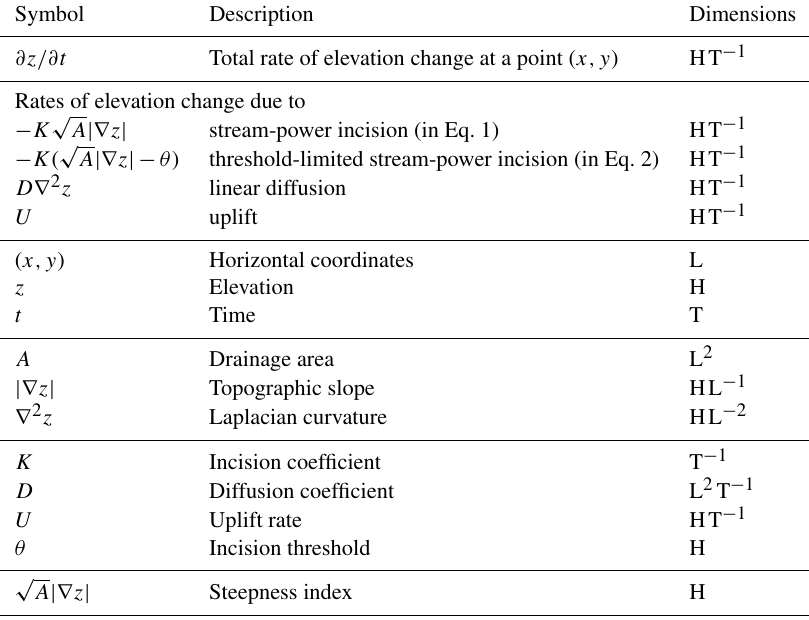
Table 1. Descriptions and dimensions of the terms, variables, and parameters in the governing equations (Eqs. 1 and 2). Dimensions are expressed in terms of the model’s fundamental dimensions of horizontal length L, vertical length (height) H, and time T. Symbol Description Dimensions ∂z/∂t Total rate of elevation change at a point ( x,y ) HT − 1 Rates of elevation change due to √ − K A |∇ z | stream-power incision (in Eq. 1) linear